Question: How would you classify this visualization?
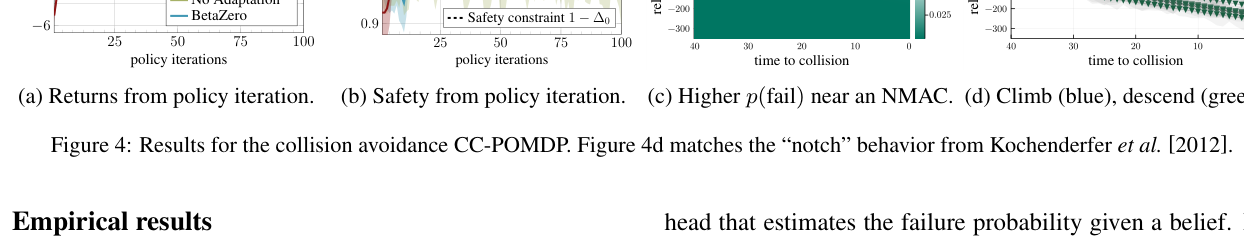
Answer: line